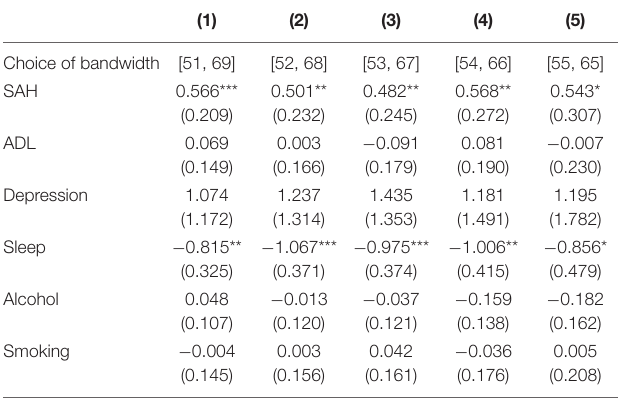
TABLE 6 | Estimated results of different